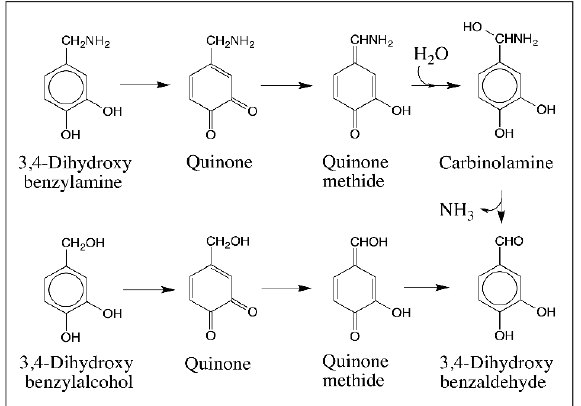
Figure 12. Oxidation chemistry of 3,4-dihydroxybenzylamine and 3,4-dihydroxybenzyl alcohol. 3,4-Dihydroxybenzylamine is easily oxidized to its quinone, which undergoes rapid nonenzymatic